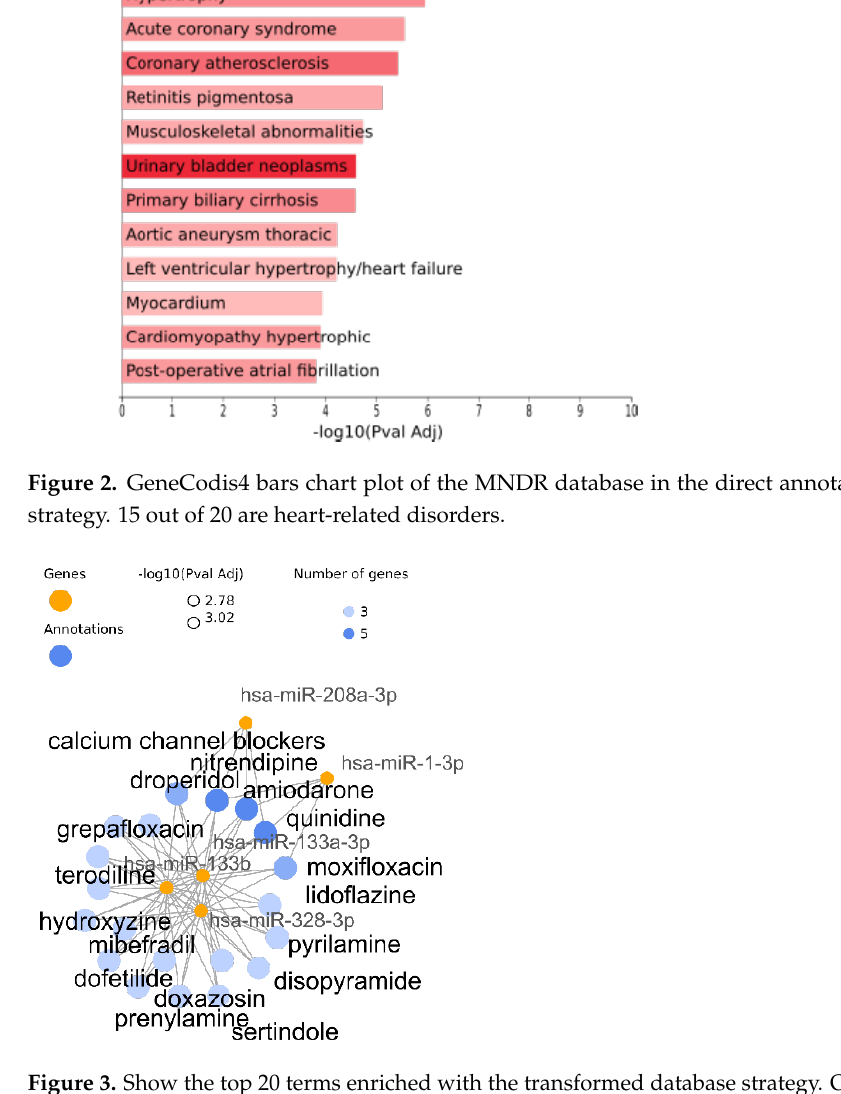
Figure 2. GeneCodis4 bars chart plot of the MNDR database in the direct annotation of miRNAs strategy. 15 out of 20 are heart-related disorders.